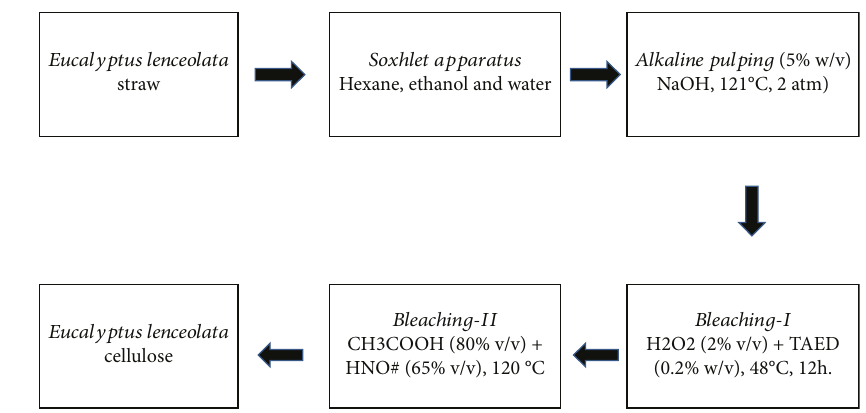
Figure 1: Scheme of the isolation steps of cellulose from Eucalyptus lenceolata . Table 1: Abbreviations for di ff erent cellulosic